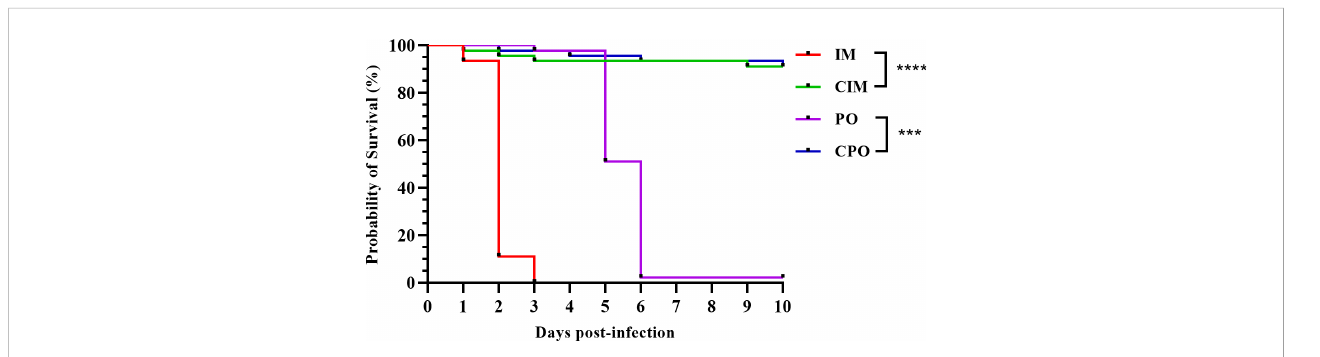
FIGURE 1 Survival curve of P. japonicus in each group of infection experiment; IM: intramuscular injection challenge group; CIM: intramuscular injection control group; PO: per os challenge group; CPO: per os control group; ***: P value was less than 0.001; ****: P value was less than